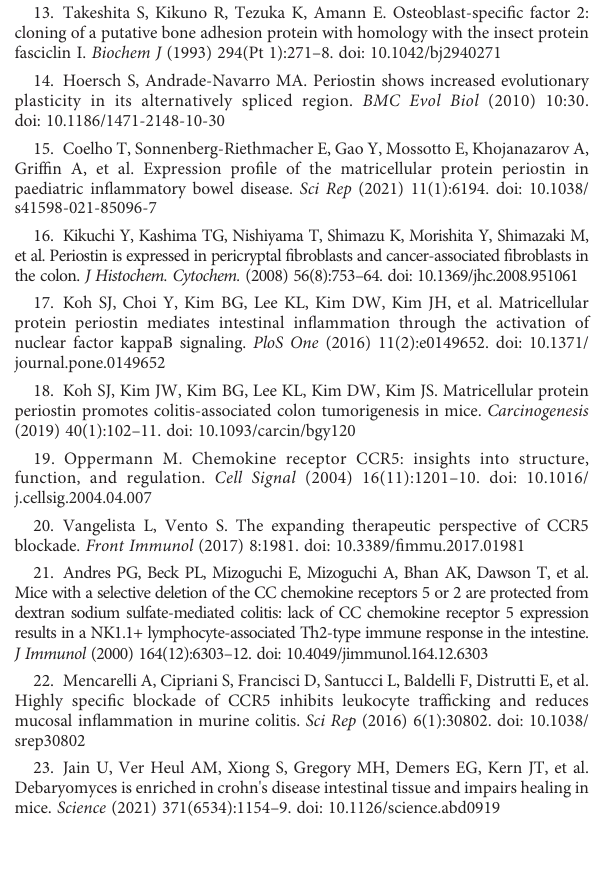
SUPPLEMENTARY FIGURE 1 Histology of small intestine following DSS induced colitis. The fi gure shows sections from small intestine at a low magni fi cation from untreated wt (A) , DSS-treated wt (B) , wt treated with DSS+MVC (C) and wt treated with DSS+ CCL5 5p12